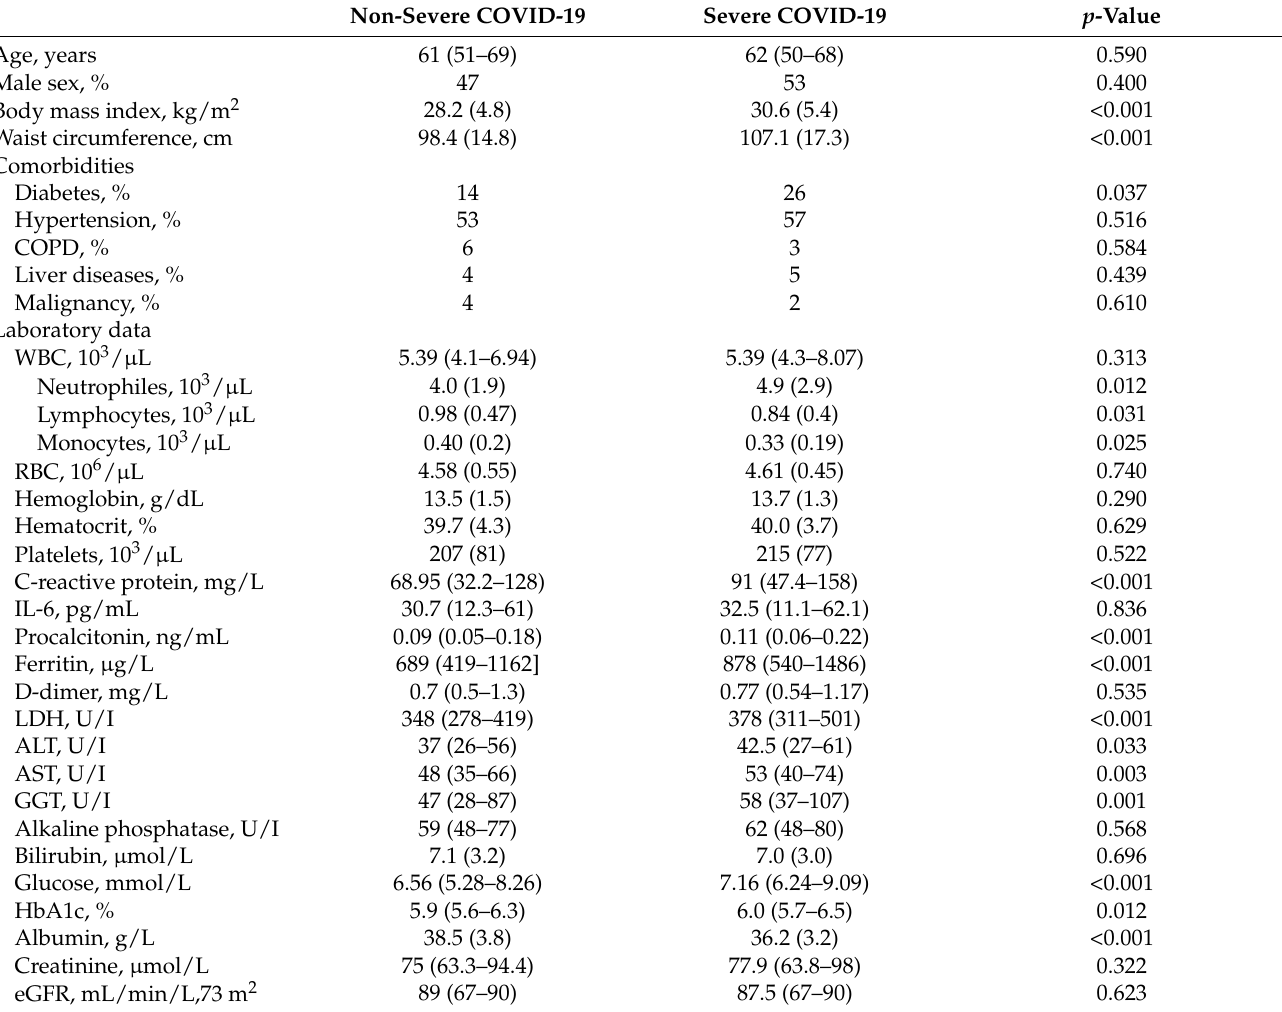
Table 1. Baseline characteristics of patients with COVID-19 according to the disease